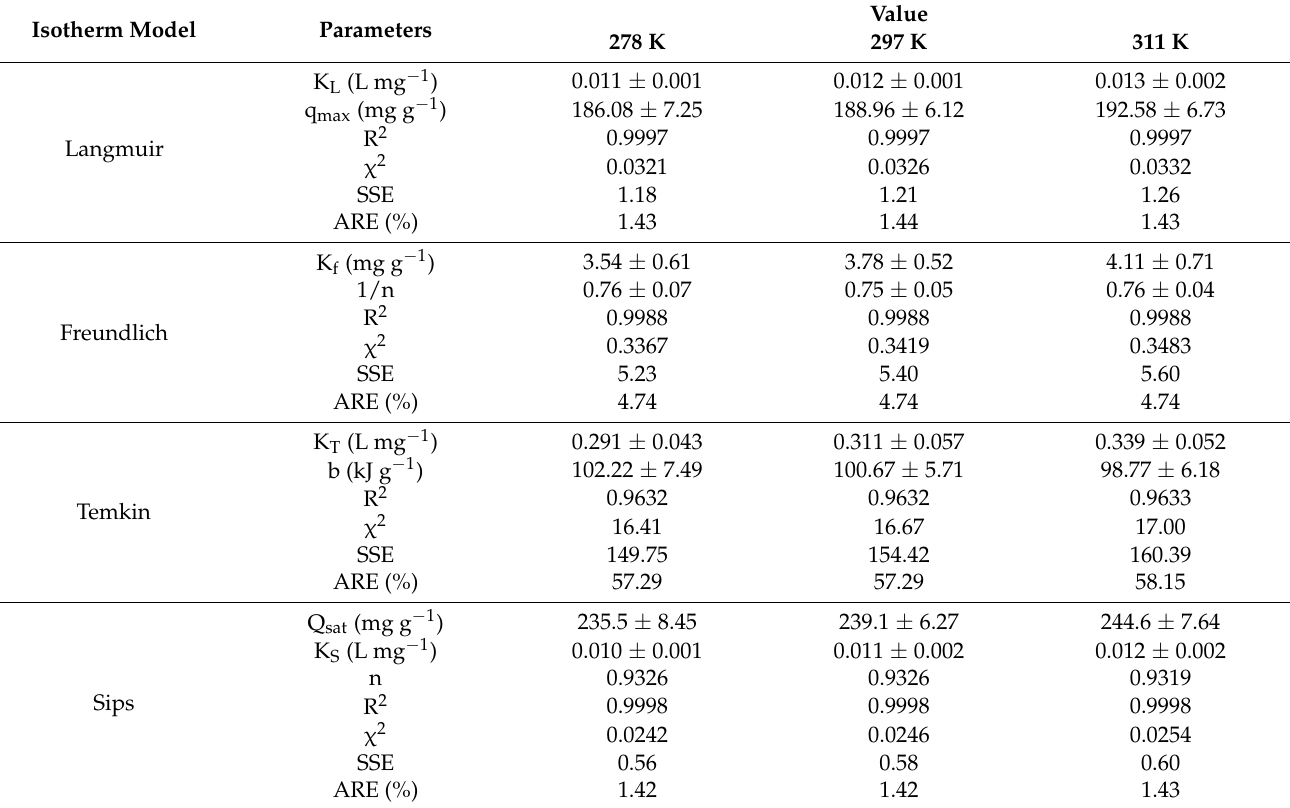
Table 2. The adsorption isotherms models constants and the corresponding error